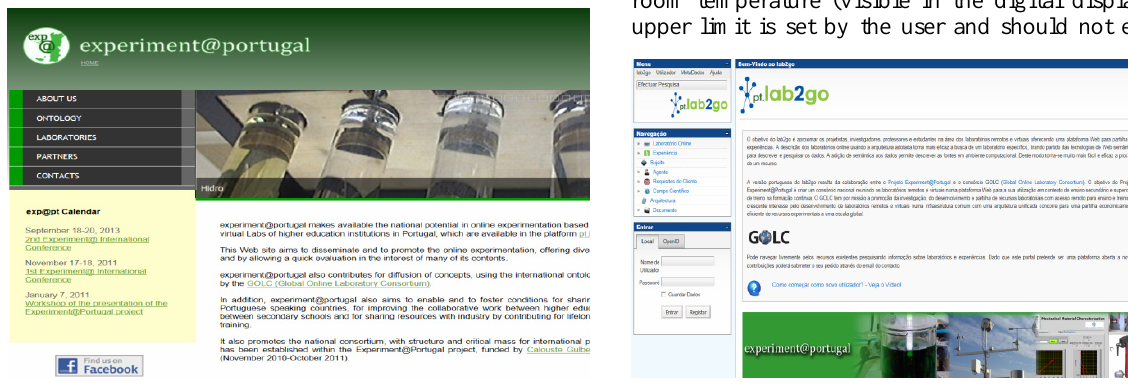
Figure 1. experiment@portugal Web page. Figure 2. Home page of the pt.lab2go